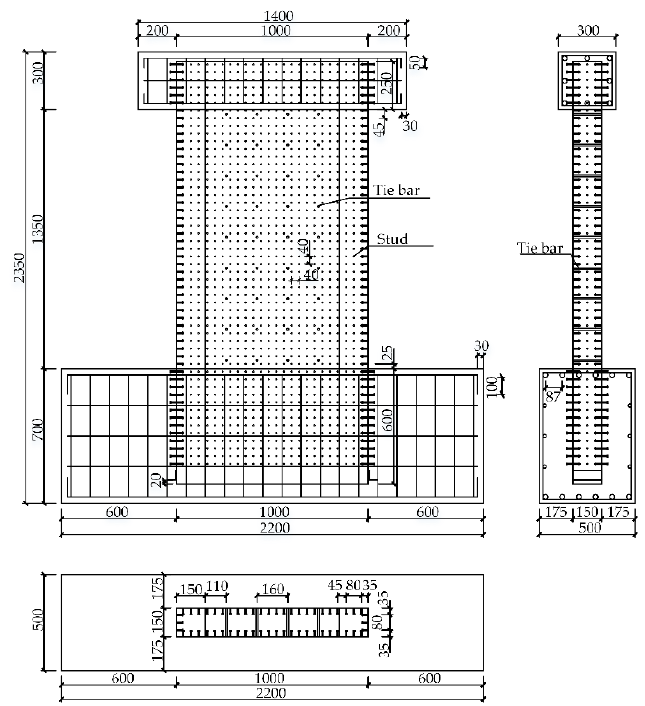
Figure 1. Diagrams of SC walls (SCW1-2) in [33].